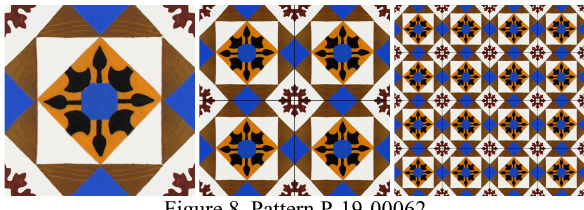
Figure 8. Pattern P-19-00062 Photo by Az Infinitum / Inês